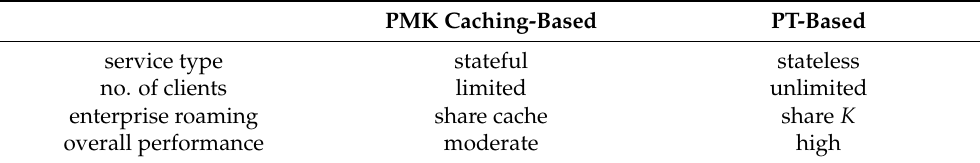
Table 2. Comparison of performance; PMK caching-based vs. PT-based re-associations. PMK Caching-Based PT-Based service